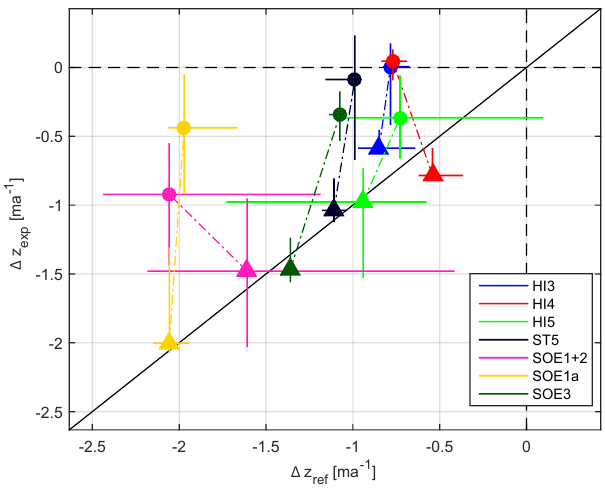
Figure 6. Median of the annual surface elevation changes in refer- ence areas ( (cid:49)z ref ), compared to the median of the annual surface el- evation changes in experimental areas ( (cid:49)z ref ) for the periods with- out (triangles) and with (circles) mass balance management. Peri- ods are given in Table 2. Solid lines show the interquartile range between the 25th and the 75th percentile. Dashed lines connect the corresponding values of one